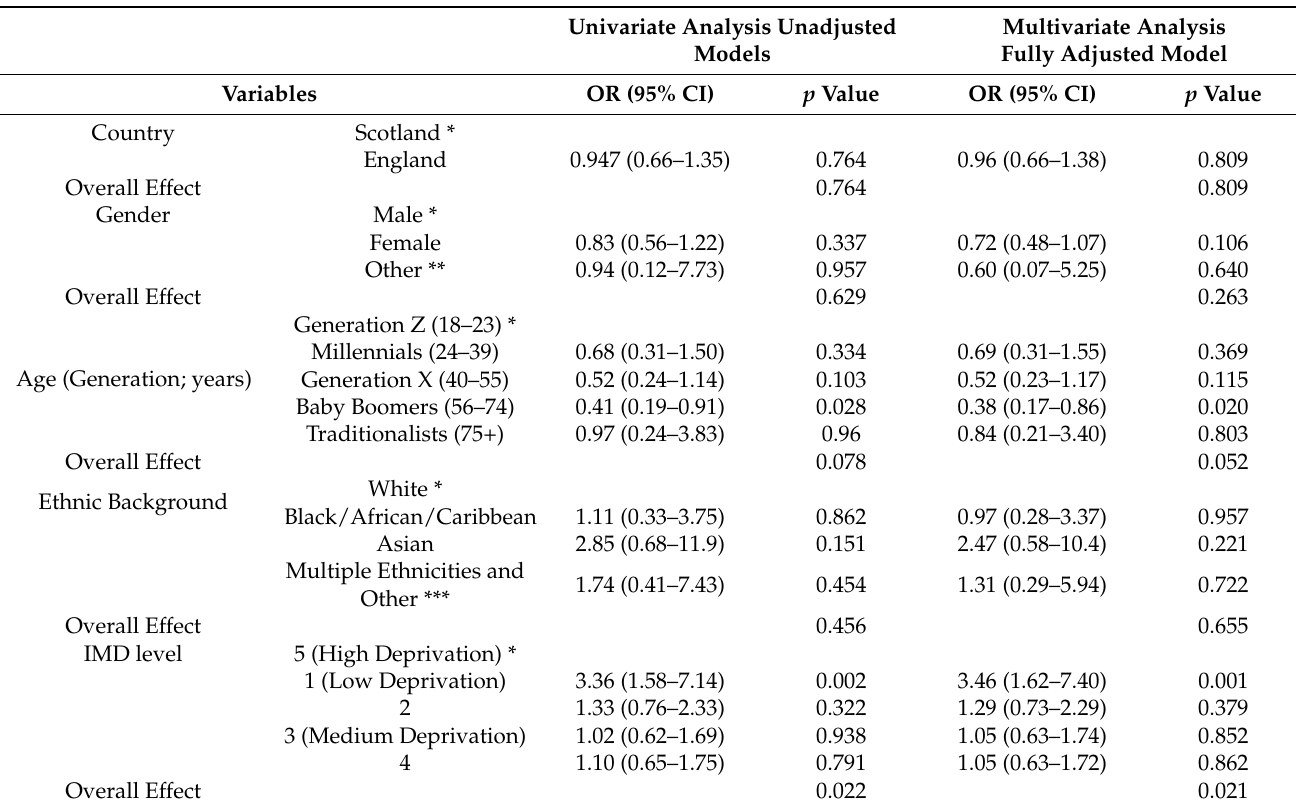
Table 3. Sociodemographic factors of wholefood plant-protein purchasing. Univariate Analysis Unadjusted Multivariate Models